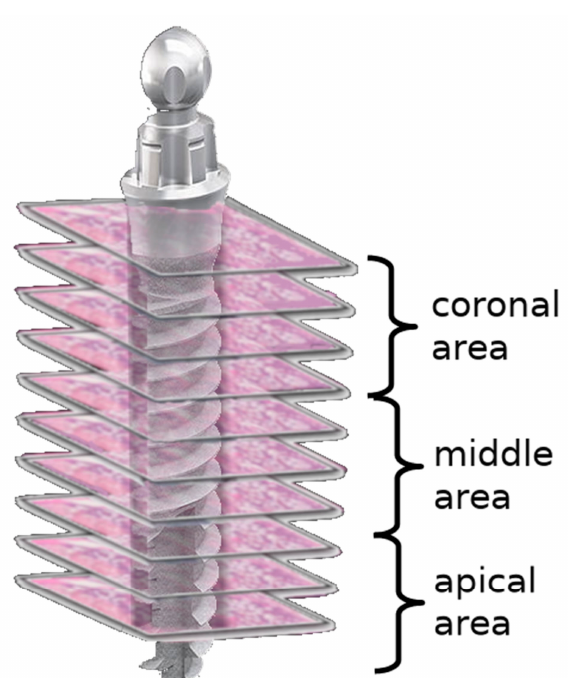
Figure 2. Scheme demonstrating the regions of interest for the evaluation of bone vitality.